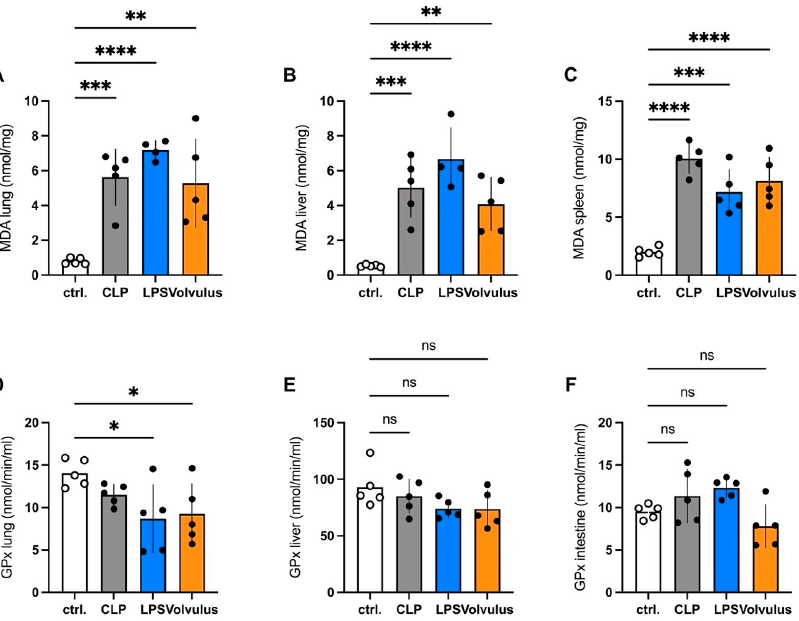
decreased only for the LPS and volvulus models in the lung. (Figure 3).